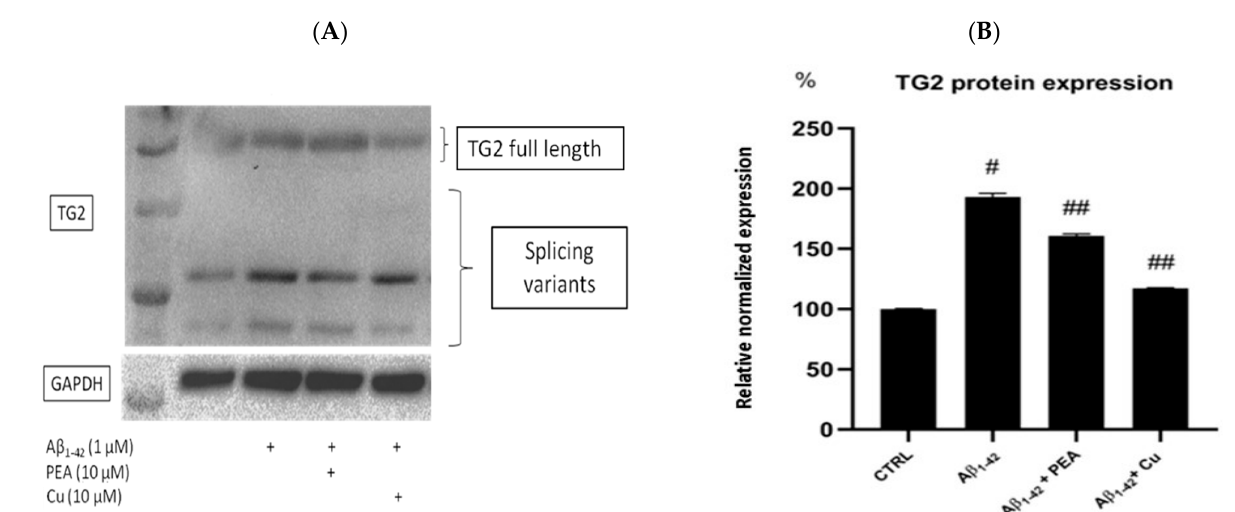
Figure 7. Panel ( A ): Western blot for TG2 expression. BV2 cells were cultured in medium supplemented or not with 10 µ M of PEA or Cu, and A β 1-42 (1 µ M) for 48 h. SDS-PAGE was blotted with antibody against TG2. GAPDH protein expression was used as loading control. The experiments were performed at least 3 different times and the results were always similar; Panel ( B ): graph shows the densitometric intensity the full lanes (TG2 full length and splicing variants)/GAPDH bands ratio. # p value < 0.05 compared with control group (NT). ## p < 0.05 compared with A β 1-42 group.